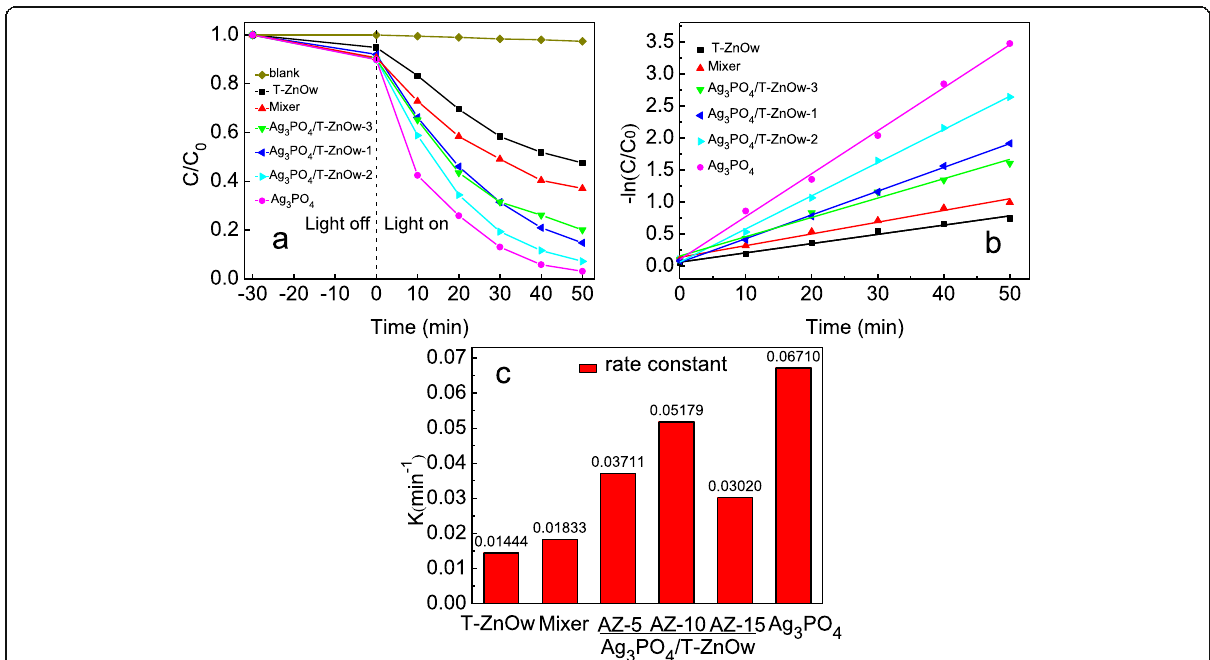
Fig. 5 a Photodegradation of RhB with different photocatalysts. b The kinetic simulation curves. c Apparent rate constants